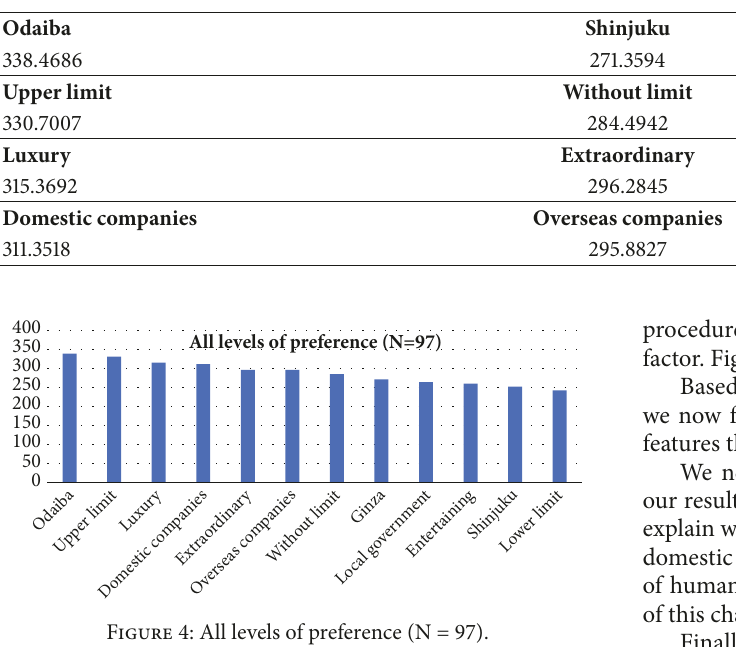
Table 5: Total level preferences for each factor.